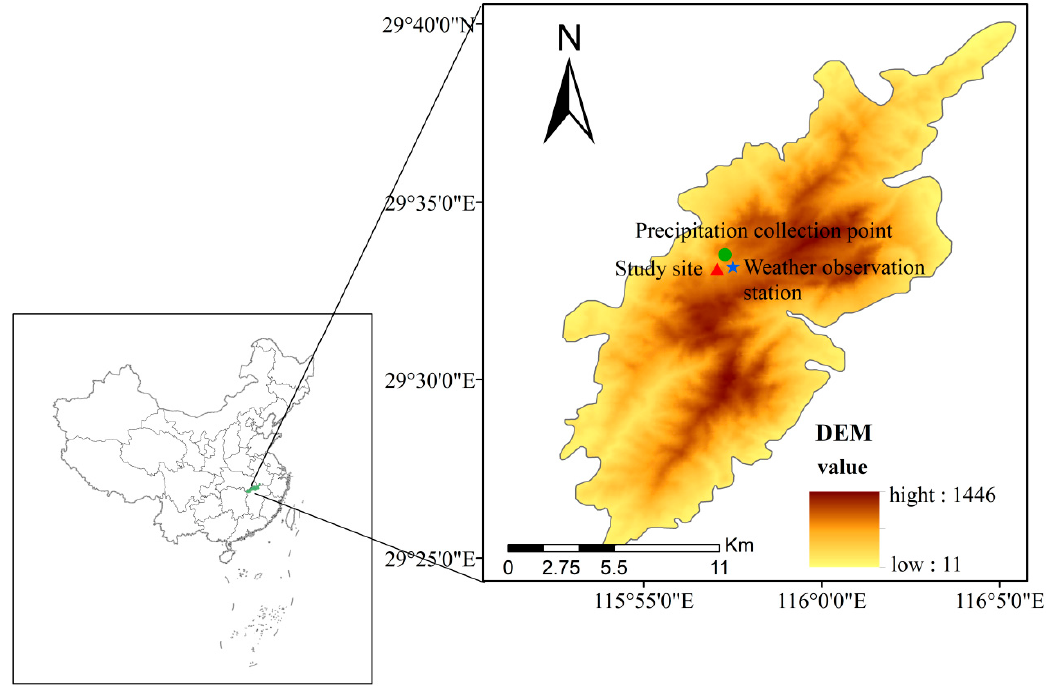
Figure 1. Location of the study